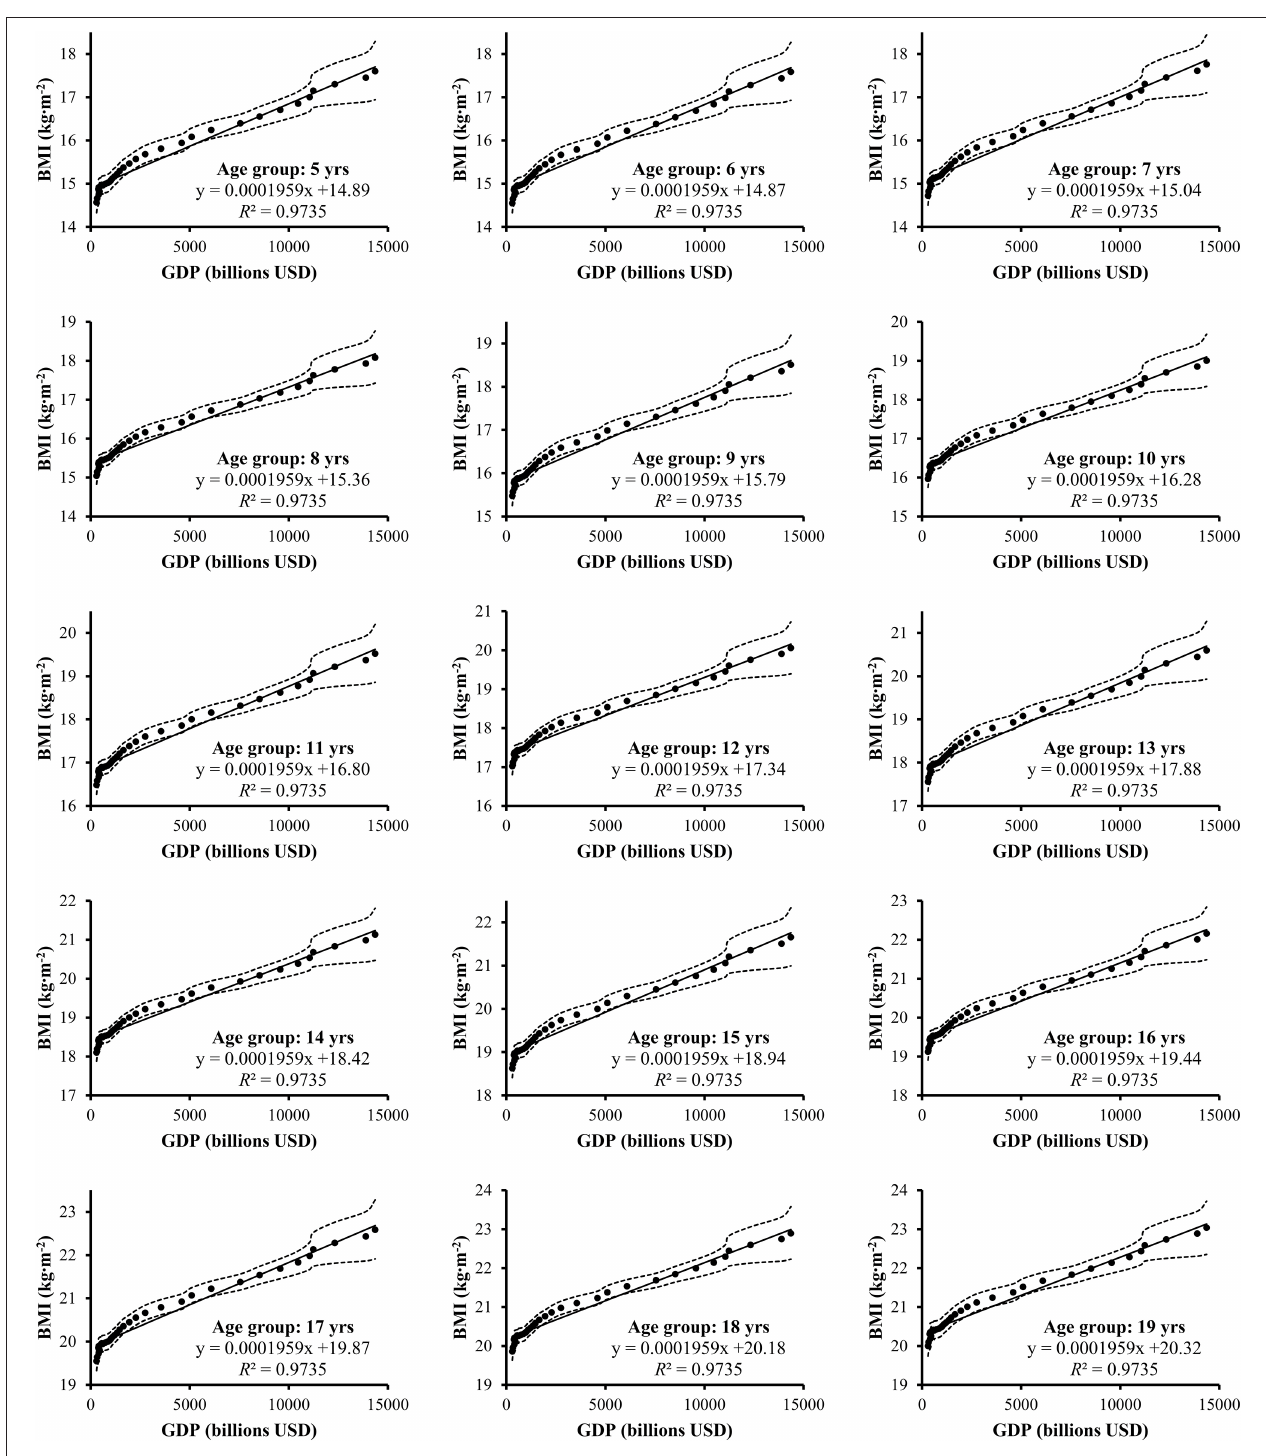
FIGURE 1 | Scatter plots with linear regression lines of gross domestic product (GDP) and body mass index (BMI) of Chinese boys aged 5–19 with respective Pearson correlation coefficients. Dotted lines represent 95% confidence interval. the epidemiological point of view, the increase in BMI was